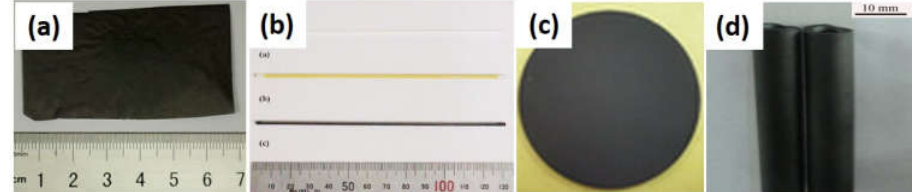
Figure 1. Flat film free-standing carbon molecular sieve (CMS) membrane ( a ), hollow fiber free-standing CMS membrane ( b ), flat supported CMS membrane ( c ) and tubular supported CMS membrane ( d ).